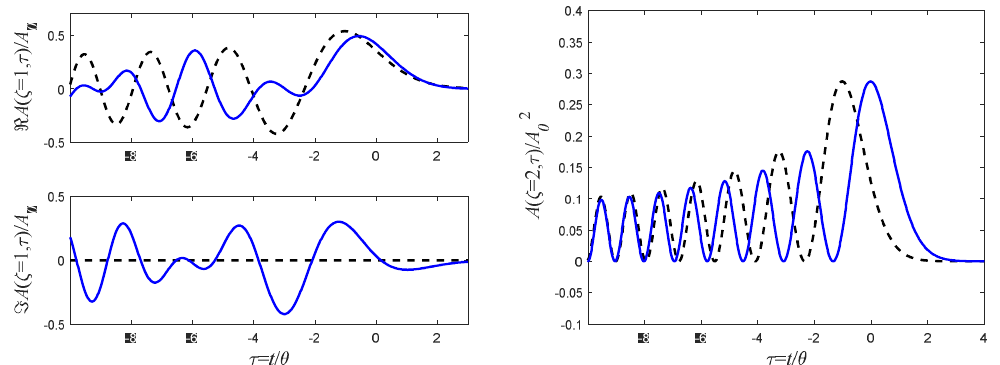
Figure 25. Presentation of the temporal dynamics of the accelerating Airy pulse (Equation (88)). On the left, the real and imaginary components of the pulse’s field are presented (for the final distance of ζ = β 2 z / θ 2 = 1), and on the right, the pulse’s intensity ( | A ( t , z ) | 2 ) is presented (for the final distance of ζ = β 2 z / θ 2 = 2).